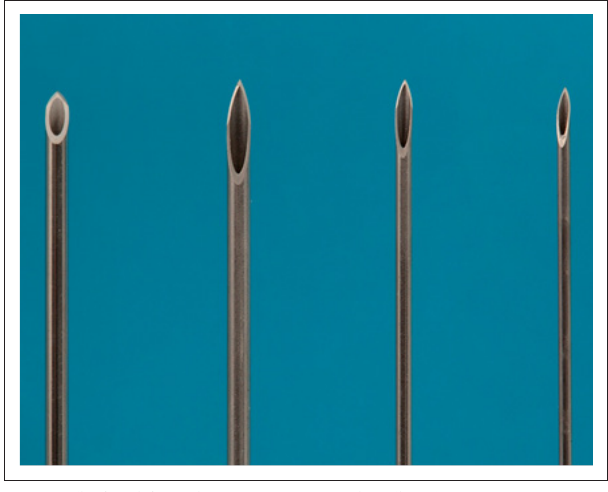
FIGURE 6: Examples of the bevels of the different needles used in the